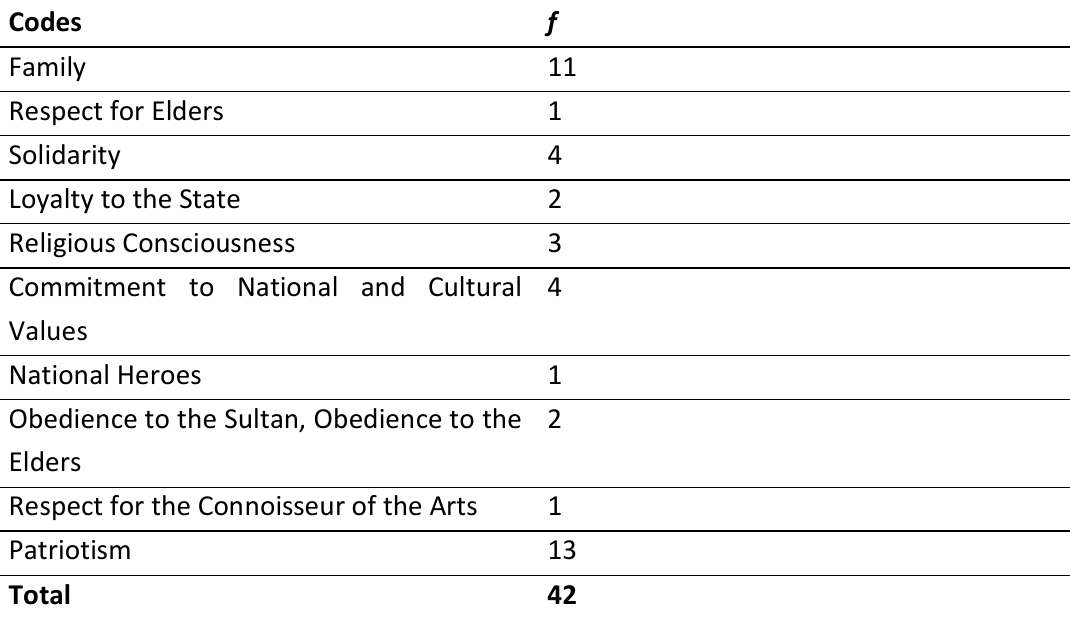
Table 8 . Codes and Statistics of National and Spiritual Consciousness Theme